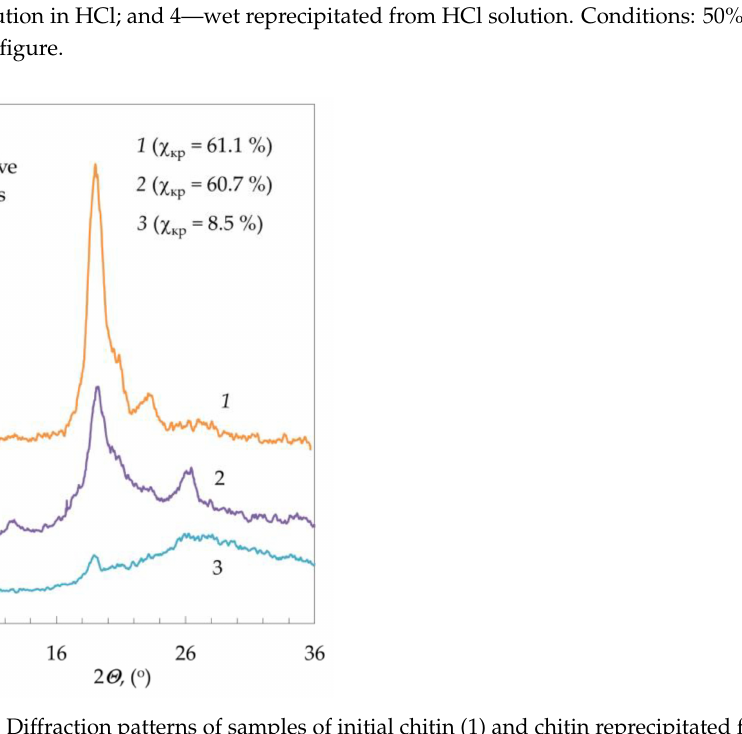
Figure 7. Diffraction patterns of samples of initial chitin (1) and chitin reprecipitated from HCl, dried in air (2), and wet (3) with different degrees of crystallinity (indicated in the figure). Original